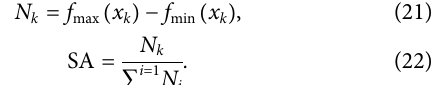
Frontiers in Materials |